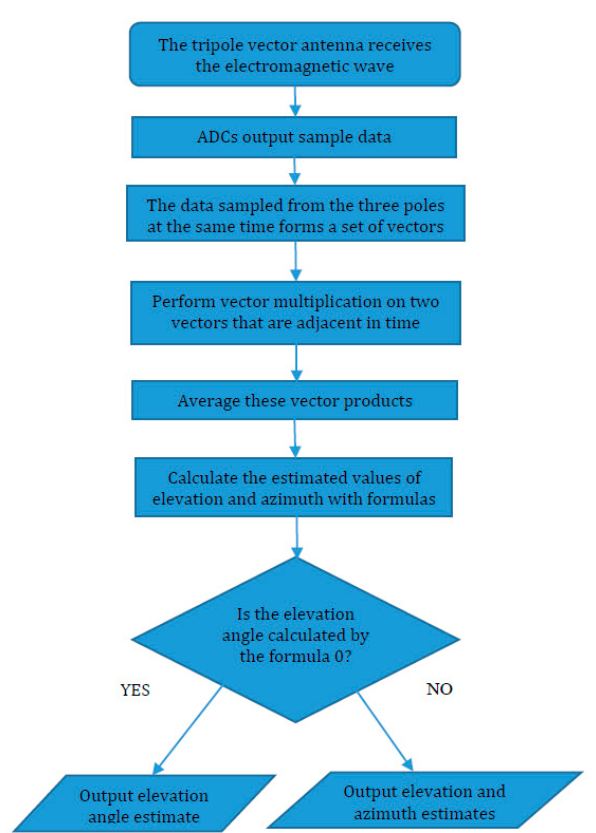
Figure 3. A flowchart about obtaining the direction of arrival (DOA).